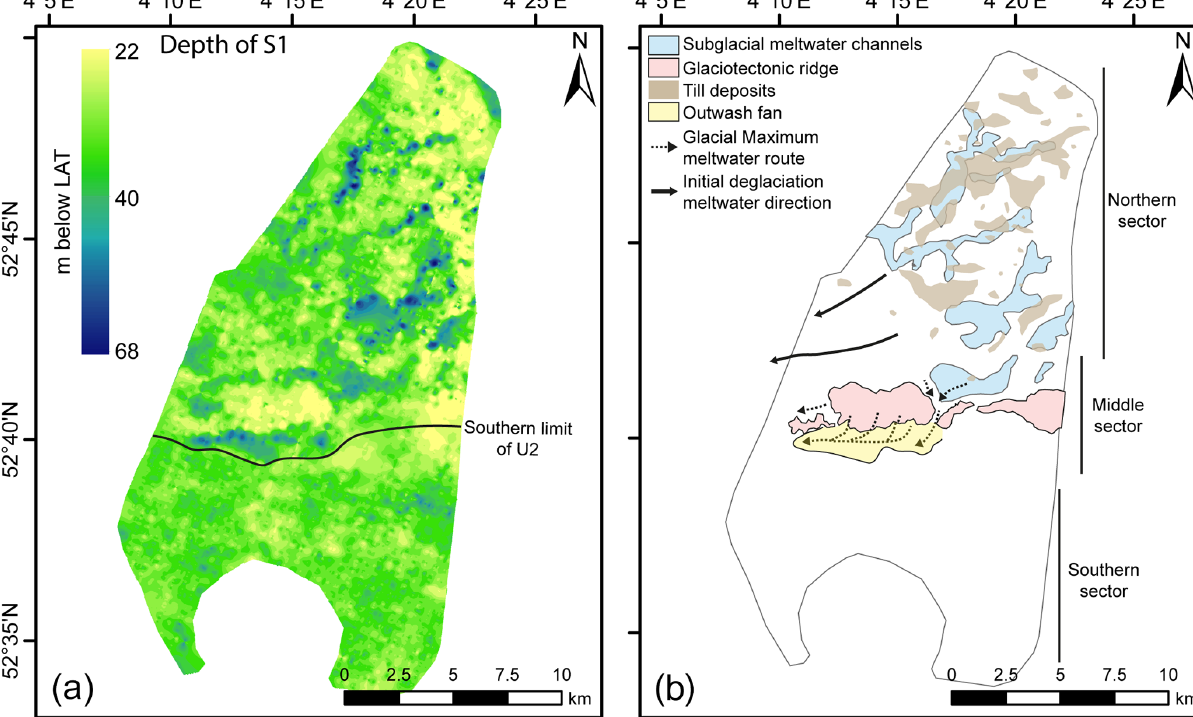
Figure 3. Seismic mapping and geological interpretation of the HKN wind-farm site. (a) Map of the depth of surface S1 (base of unit U2; see also Figs. 2 and 4). (b) Landform interpretation showing subglacial meltwater channels, glaciotectonic ridges, till deposits, and an outwash fan mapped in the study area. Meltwater direction during the early deglaciation has been inferred from the general relief and slope of surface S1 and the distribution of glaciofluvial